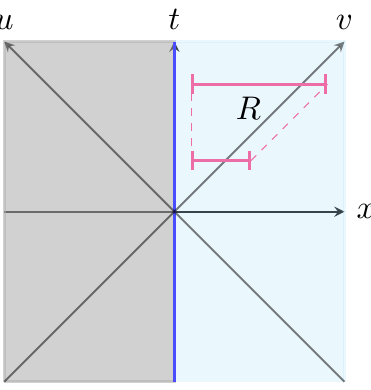
Figure 11 . The static moving mirror trajectory (3.24) probed by an expanding interval R = [0 . 1 , 0 . 5 + t ] .